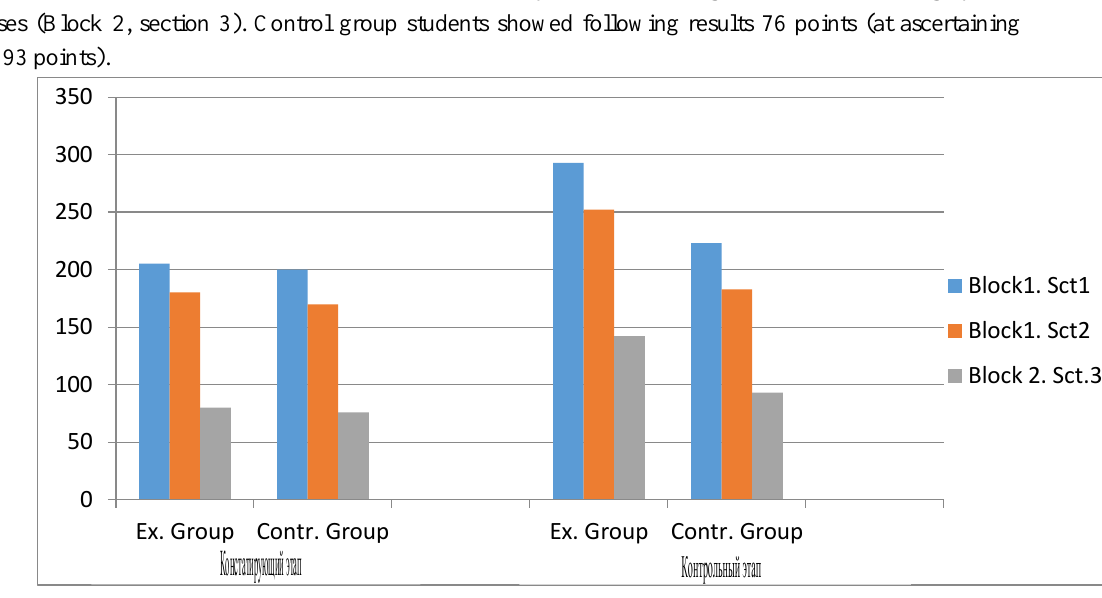
Figure 6. Test results of students concerning question of Block 1 at ascertaining and control stage of